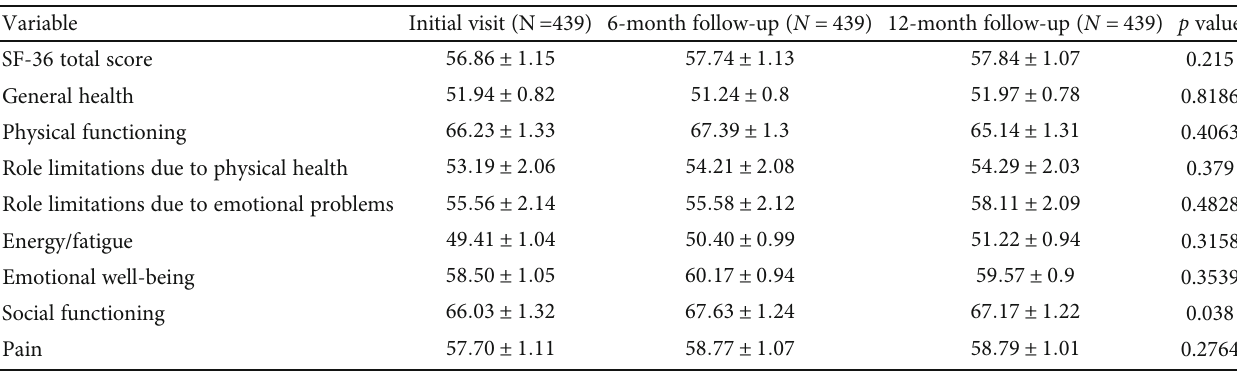
Table 3: Overall and domain-speci fi c SF-36 scores over time.